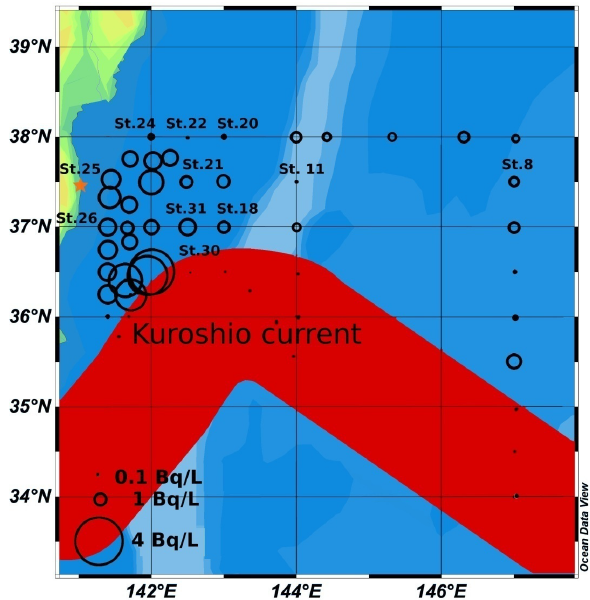
Fig. 5 Fig. 5. Distribution of 137 Cs in surface waters offshore Fukushima. Data obtained in the present work (identified by St. numbers), as well as those of Buesseler et al. (2012), both from the KOK expedi- tion, are